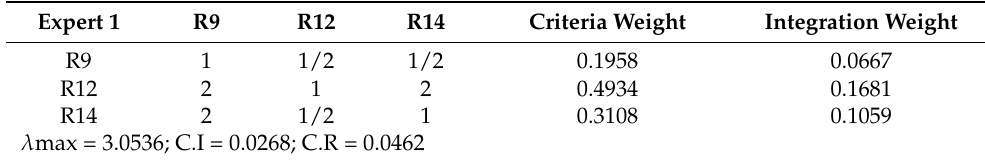
Table 9. The consistency and weight value of supplier material supply (RA2) factors. Expert 1